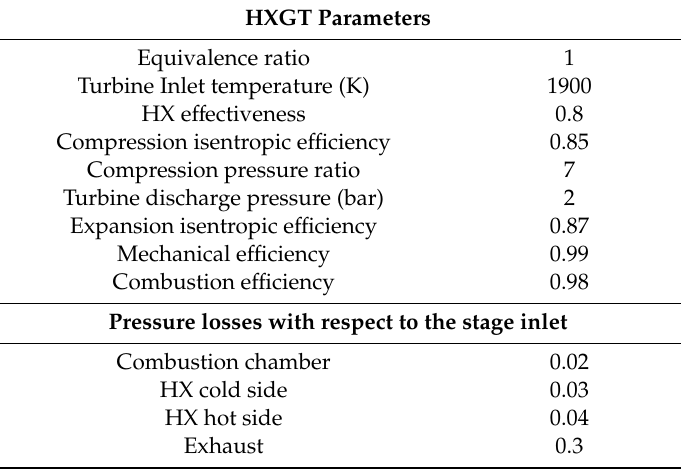
Table 3. Specifications of the heat exchanged gas turbine cycle